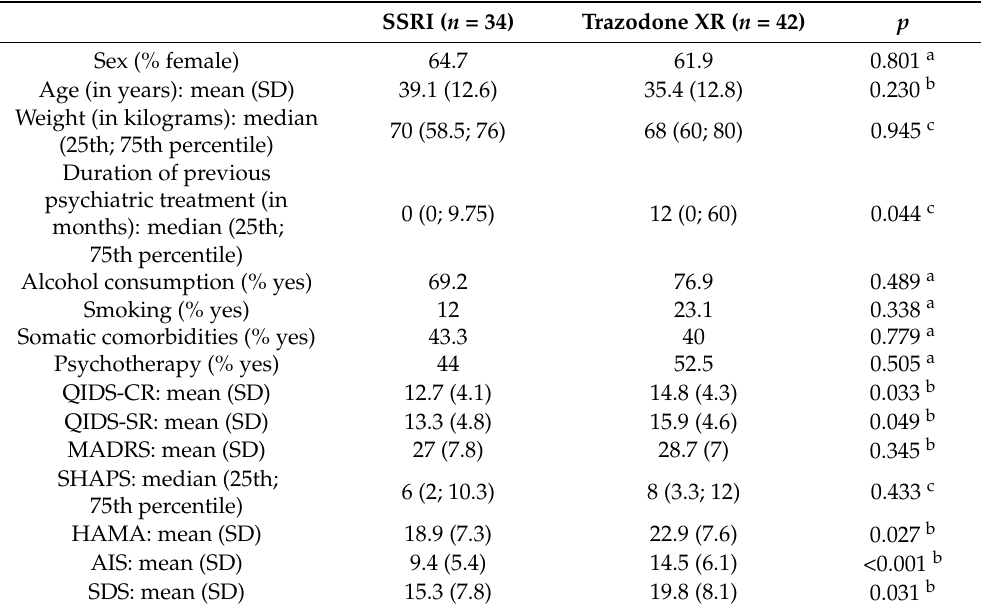
a , chi-square test; b , independent sample t -test; c , Mann–Whitney U test.